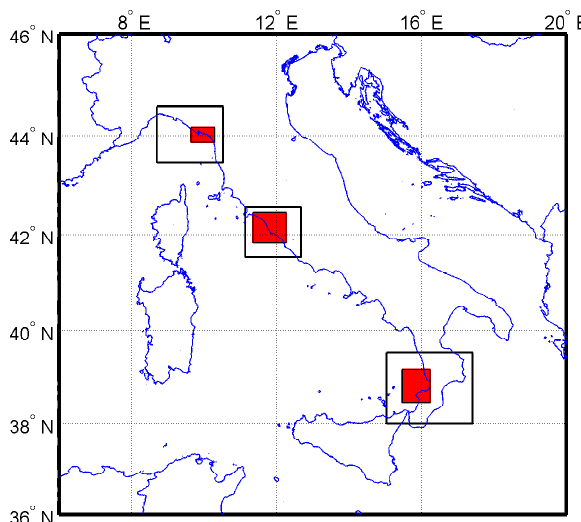
Fig. 1. Regional (black boxes) and coastal areas (red boxes) nested in the Mediterranean Sea